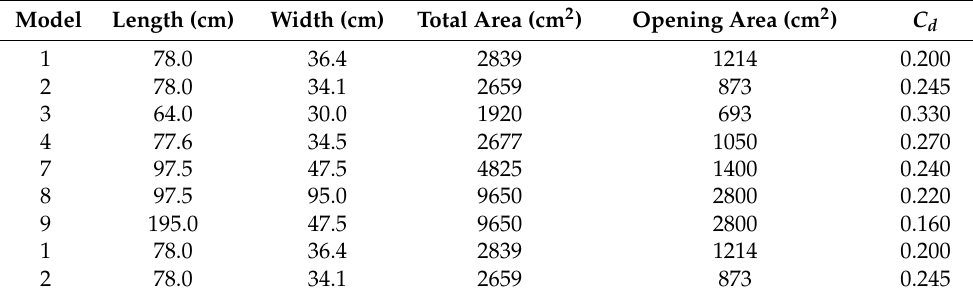
Table 2. Characteristics of the grates